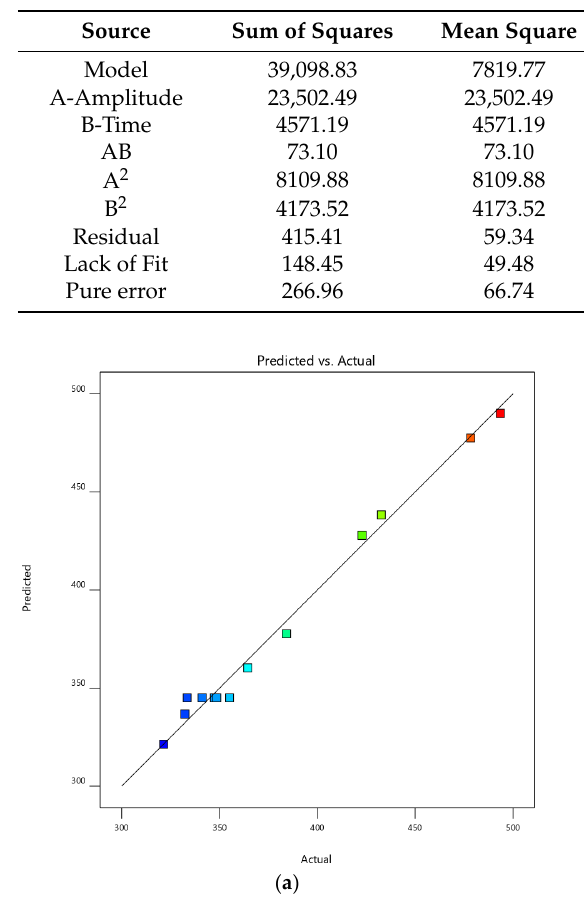
Table 2. ANOVA of quadratic model.